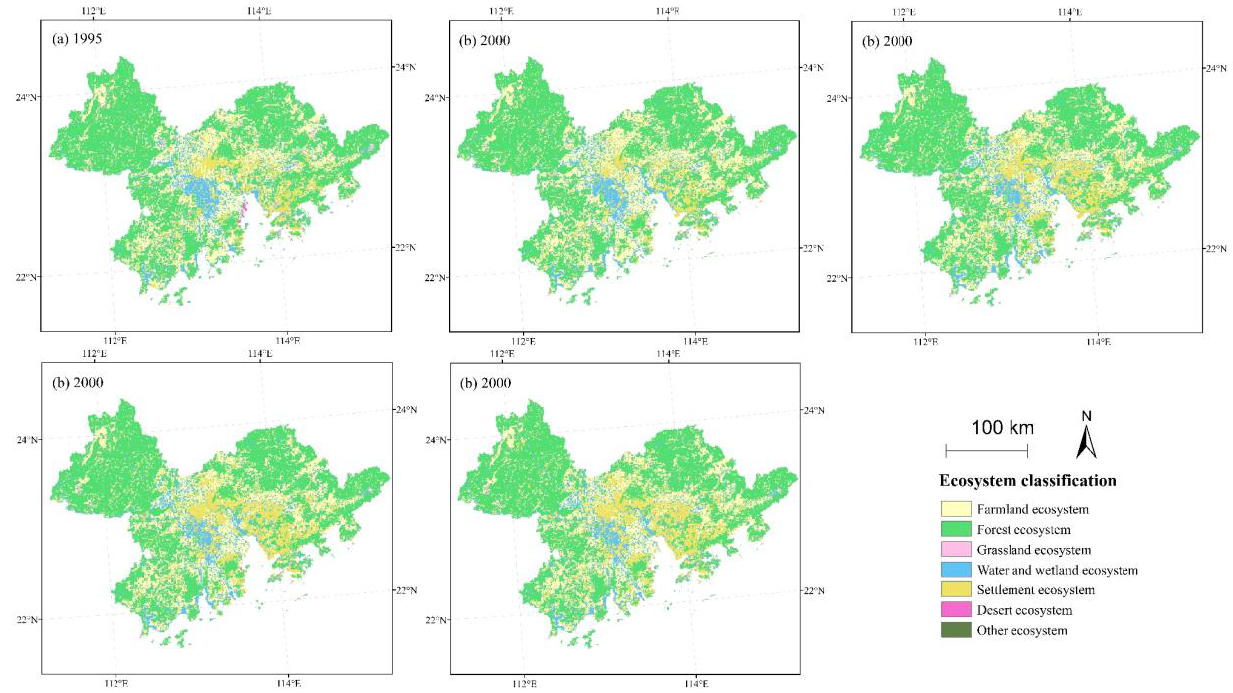
Figure A5. The spatial pattern of terrestrial ecosystem classification in ( a ) 1995, ( b ) 2000, ( c ) 2005, ( d ) 2010, and ( e ) 2015. Table A1 shows the absolute value of Kendall’s correlation coefficient for each LULC type and threat factor, which were used to replace the original parameter of the InVEST- HQ model. Table A1. The sensitivity score of habitat types to threat factors.